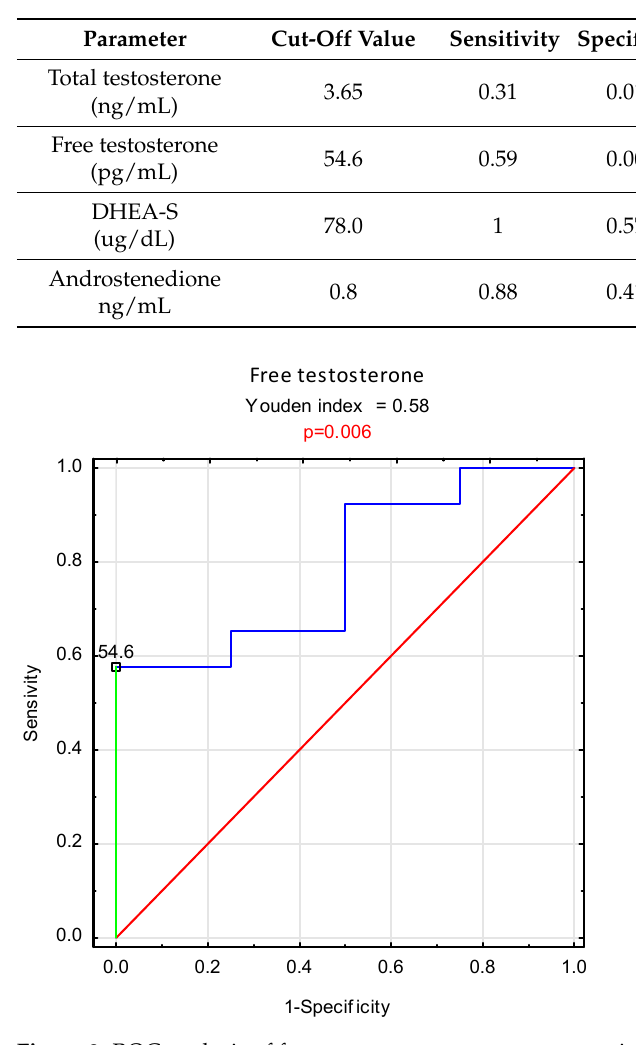
Figure 3. ROC analysis of free testosterone serum concentration in the prognosis prediction in men undergoing